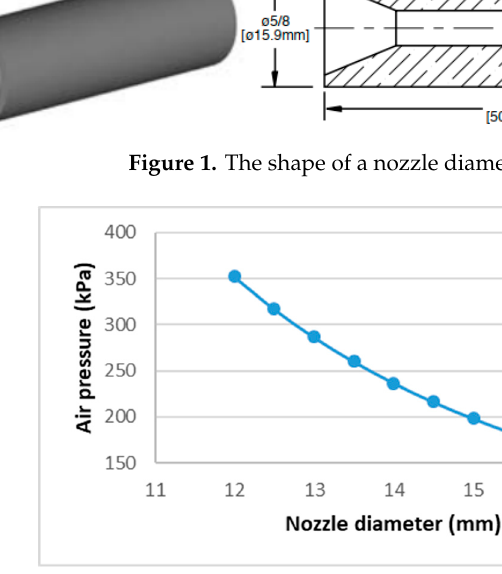
Figure 2. Air pressure versus nozzle diameter.